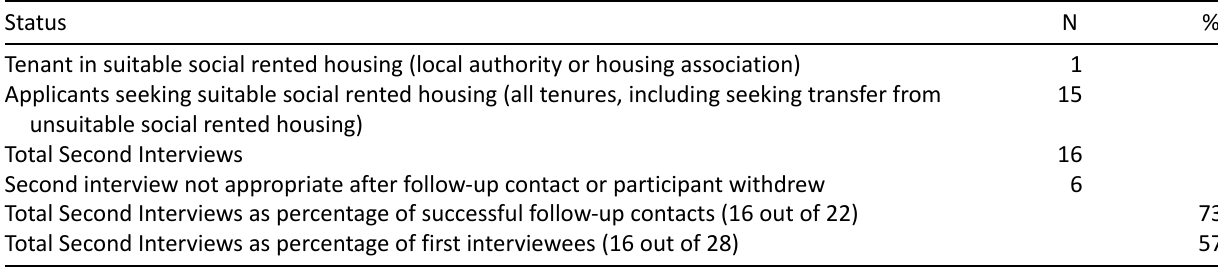
Table 3. Housing application/lettings status of participants at second interview (N = 15 households, up to one year after first